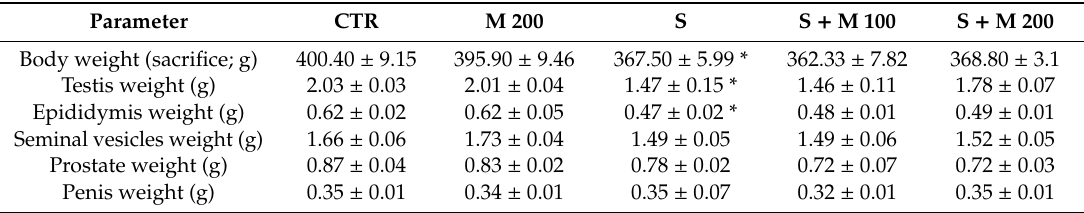
Table 1. E ff ect of MOTILIPERM on body weight and reproductive organ weight in immobilization stress-treated male Sprague Dawley (SD)